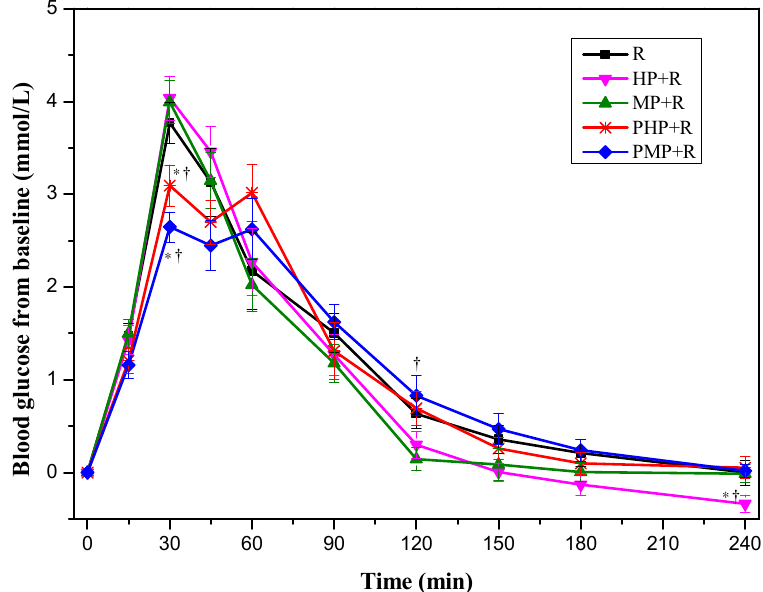
Figure 3. Blood glucose changes from baseline for mixed test foods (n = 17). R, rice; P, potatoes; HP, highly cooked potatoes; MP, minimally cooked potatoes. HP + R, co-ingestion of HP and rice; MP + R, co-ingestion of MP and rice; PHP + R, preload HP with rice; PMP + R, preload MP with rice. Values are shown as the mean value with their standard errors represented by vertical bars. * Test meals different from rice, † preload different from co-ingestion test meals ( p < 0.05).